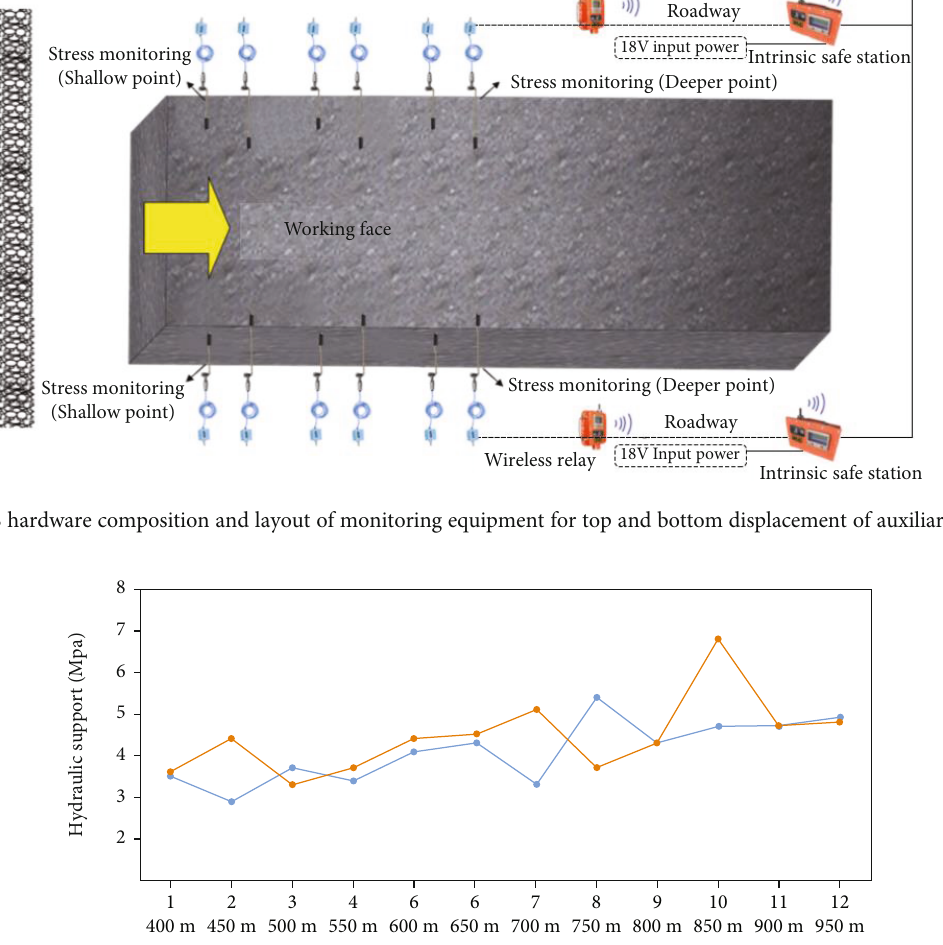
Distance from the setup